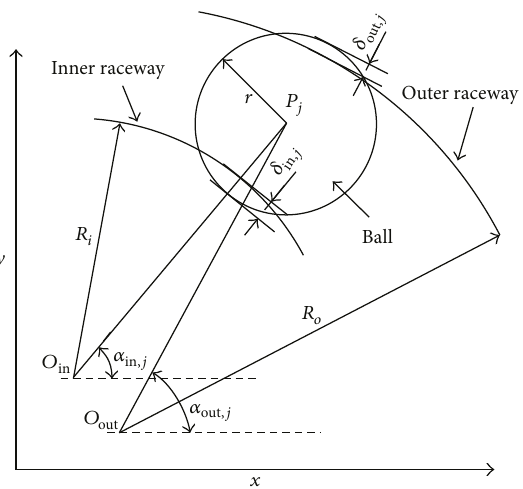
Figure 3: Relationships between the motions of the components of a ball